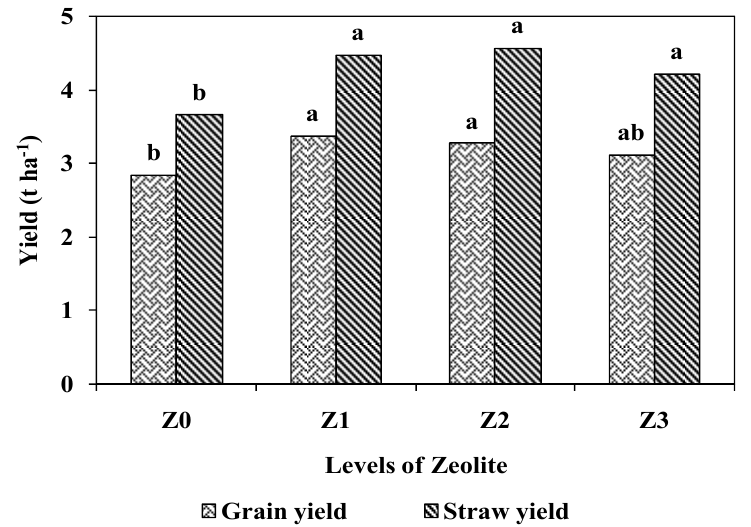
Figure 12. Effect of zeolite application on LAI, Tr, Sc and Chalkiness of rice. Tr: Transpiration rate (mmol m –2 s –1 ); Sc: Stomatal conductance (mol m –2 s –1 ); Z 0 : No Zeolite; Z 15 : Zeolite at 15 t ha − 1 . Within treatments, different letters indicate significant differences at p ≤ 0.05(otherwise statistically at par). Modified from Zheng et al. [32].